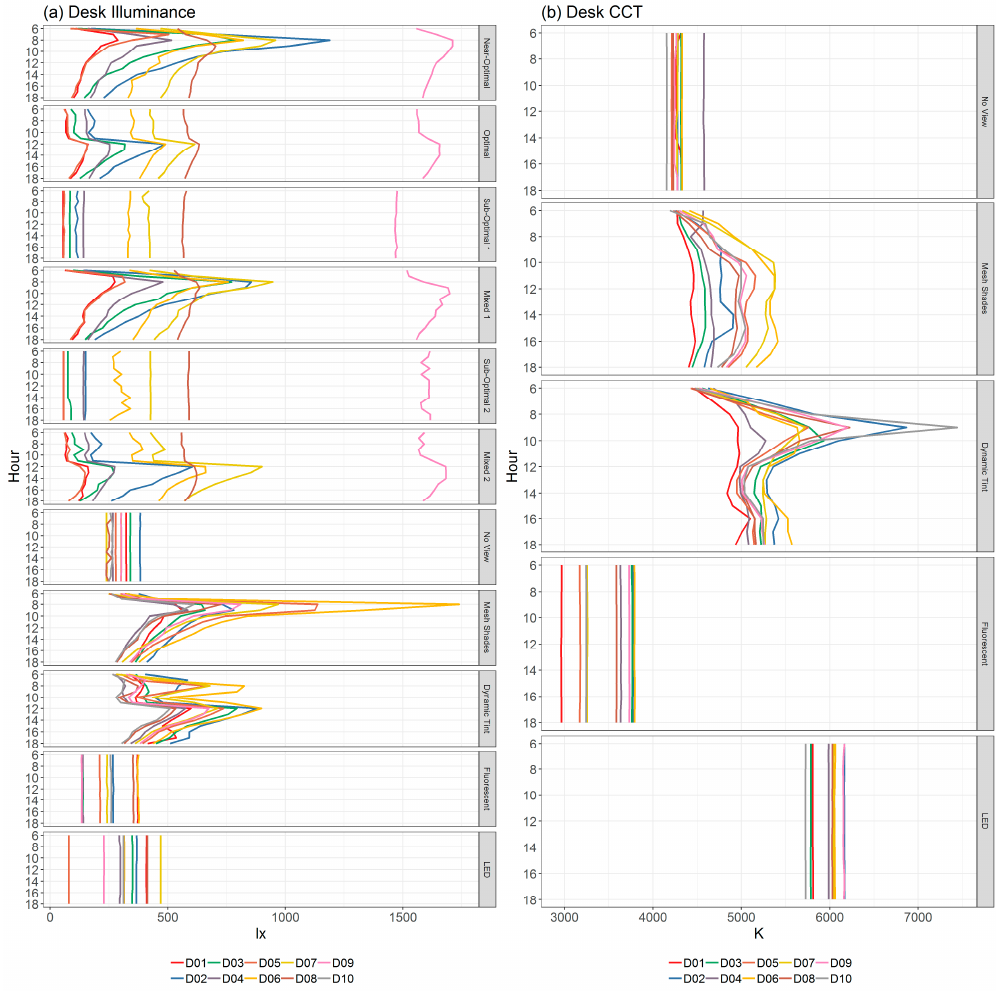
Figure 6. Hourly spatial variability in ( a ) desk illuminance and ( b ) desk CCT (no data from multi-IEQ study) during each experimental condition of three office experiments. 585